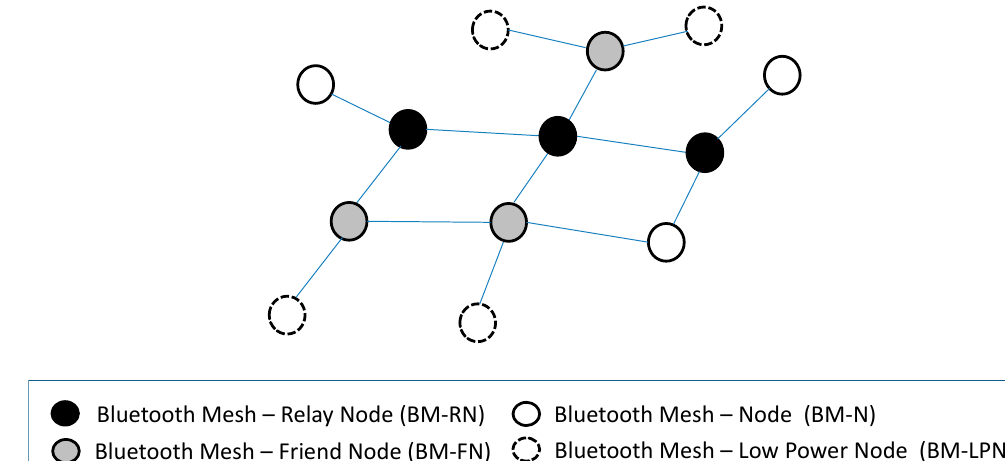
Figure 2. Bluetooth Mesh network topology and device roles.